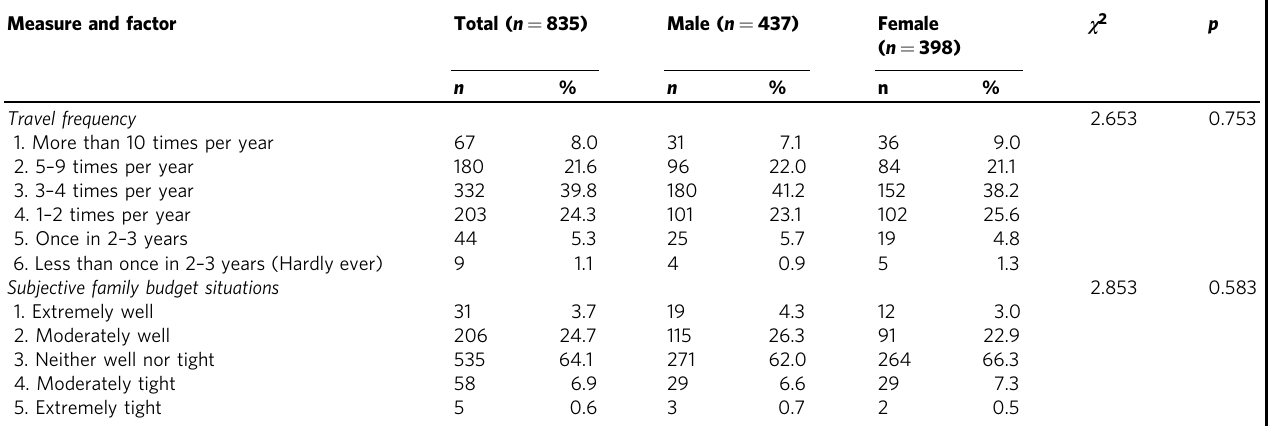
Table 2 Travel frequency and subjective family budget situations of the participants.